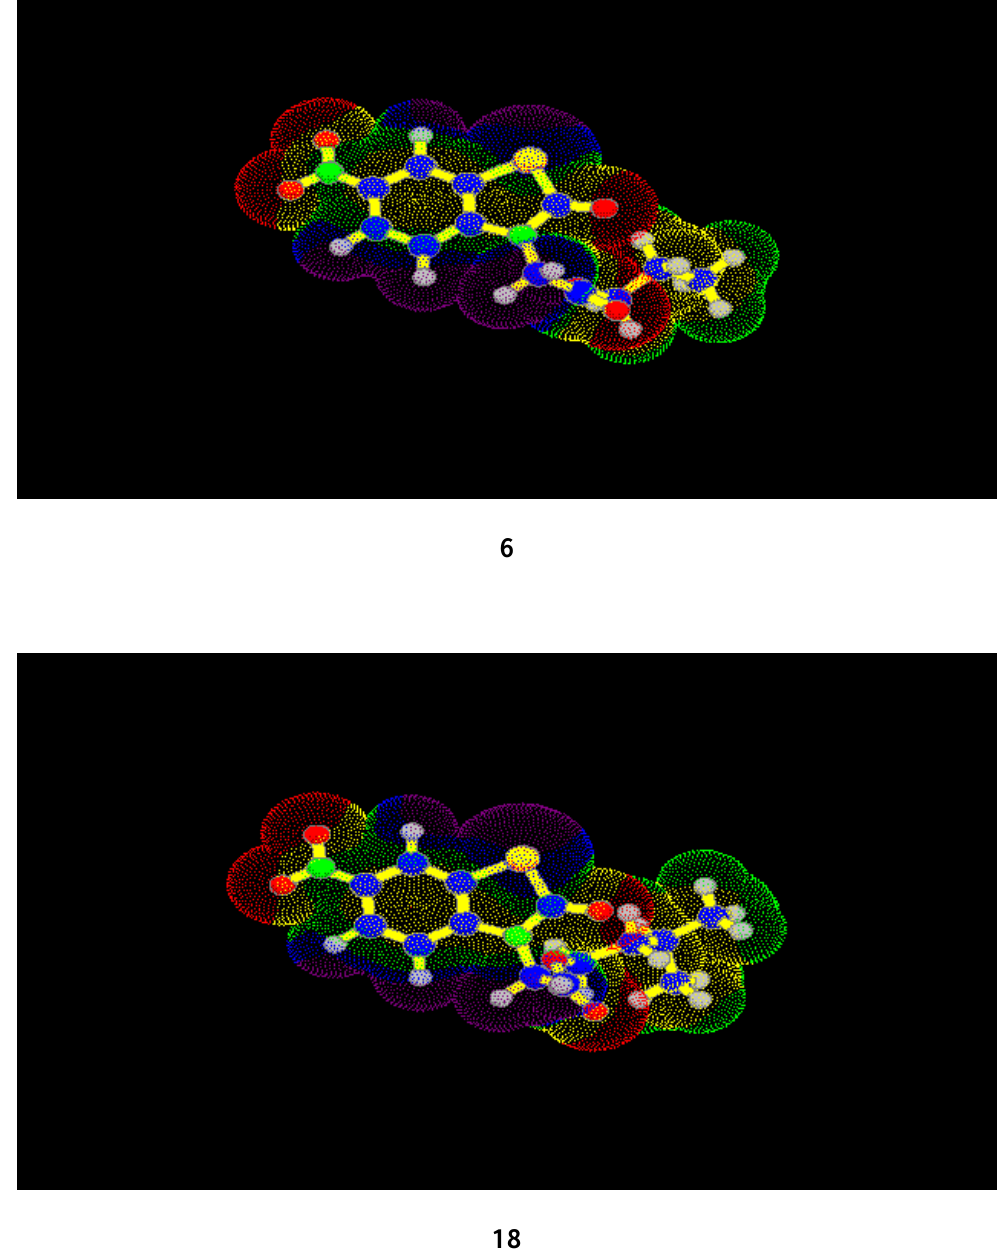
Figure 1. Structure and MEP on the van der Waals surface of 6-nitro ( 6 and 18 )